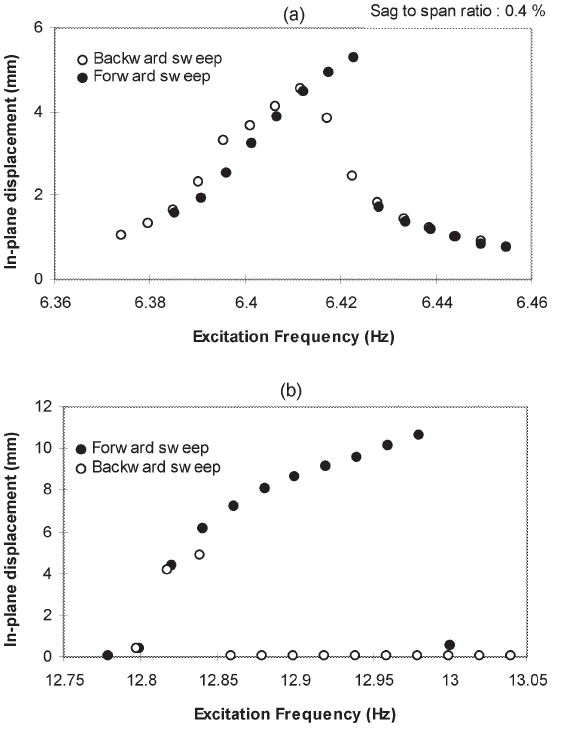
Fig. 10. Frequency response function between the active tendon dis- placement and the in-plane vibration at (a) the primary resonance ! 1 , and (b) the parametric resonance 2 ! 1 .